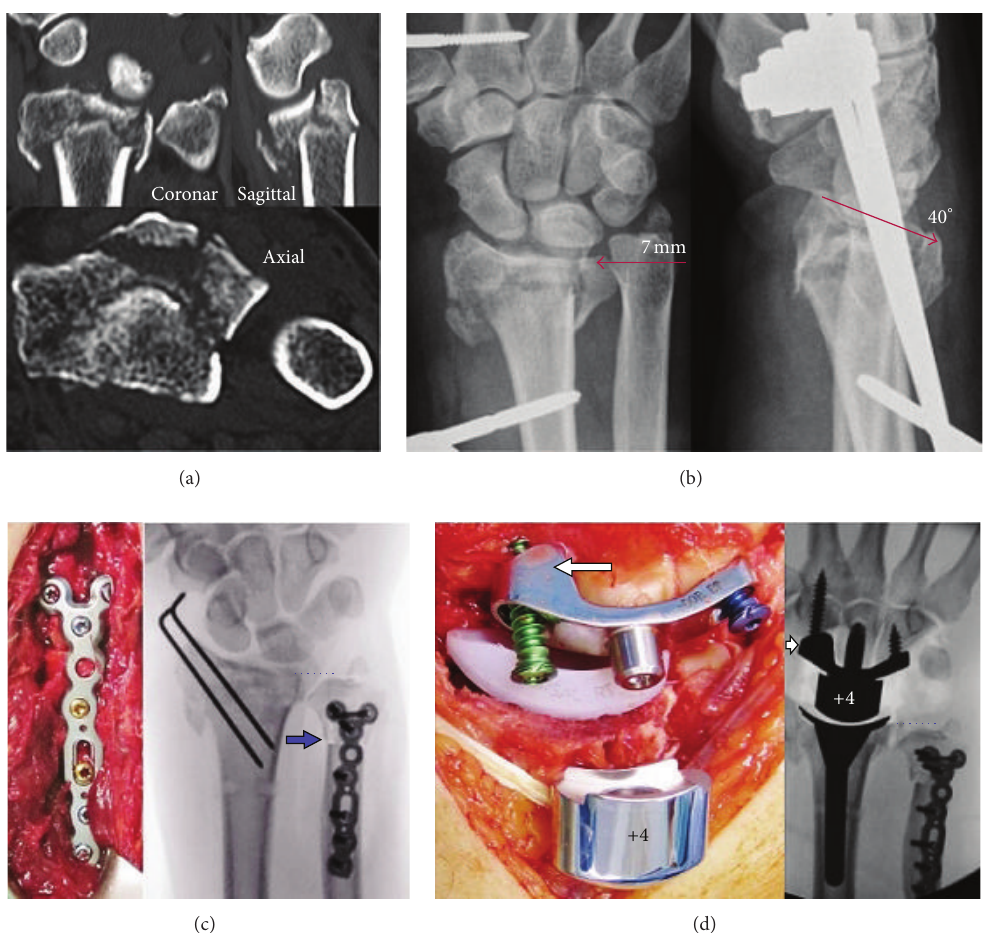
Figure 2: Case report 1 (preoperative and surgical procedures): (a) initial CT images in three levels; (b) AP and lateral radiographs after closed reduction and external fixation; (c) intraoperative clinical photo and AP fluoroscopy after removal of external fixateur, percutaneous pinning, and USO ( arrow ) showing no ulnar-positive variance ( points ); note the displaced ulnar styloid base fracture; (d) intraoperative clinical photo and AP fluoroscopy after Maestro WRS insertion showing correct position of implant; note the scaphoid augment of the carpal component after complete scaphoid excision ( arrow